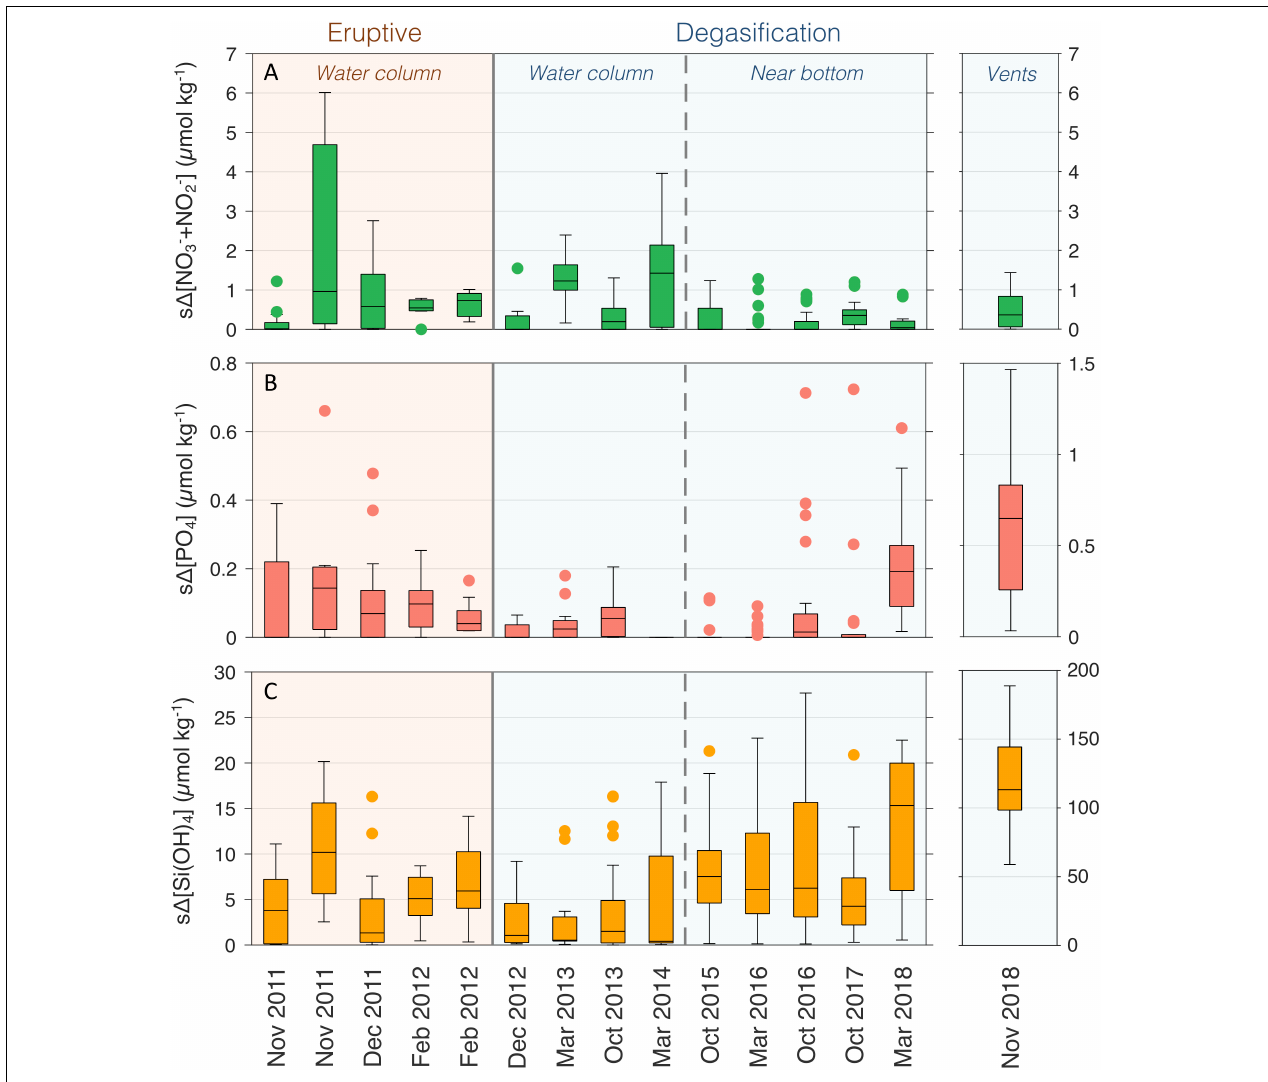
FIGURE 3 | Significant anomalies of (A) nitrate, (B) phosphate, and (C) silicate for each cruise. Boxplots show the median, quartiles, and outliers of the datasets. Volcanic stage (eruptive/degasification) and sample type according to the sampling methodology (water column/near bottom/vents) are